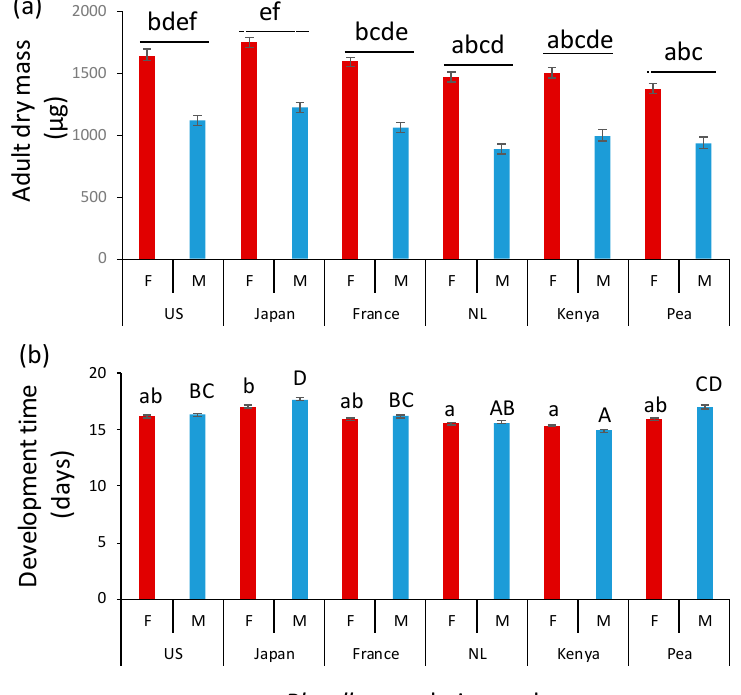
Figure 1. Survival to adulthood (blue bars: mean proportion ± SE) of Plutella xylostella caterpillars from populations originating from the US, Japan, France, the Netherlands (NL), and Kenya, as well as a population adapted to pea in Kenya. Orange bars present the proportion of P. xylostella pupae that did not emerge as adults. Orange bars with the same letter are not significantly different (blue bars are not significantly different from each other). For each population, 13 caterpillars were introduced on each of 10 to12 Brassica rapa plants.